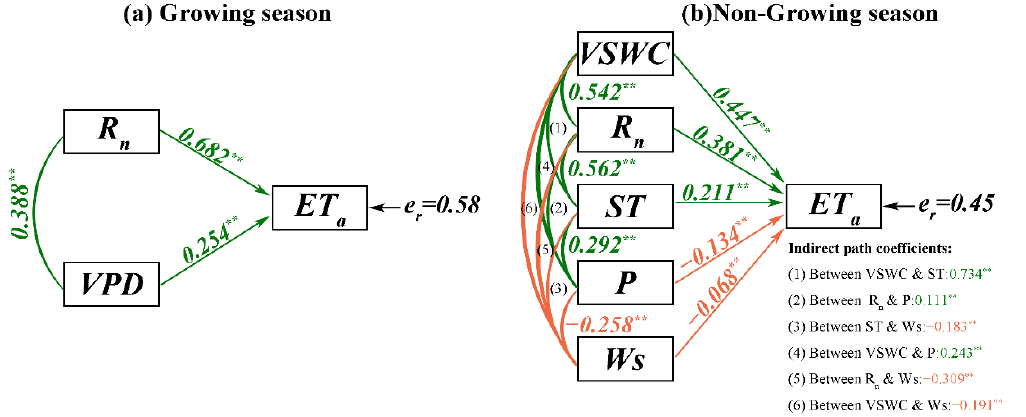
Figure 8. The structures of MF G and MF NG given by path analysis during the ( a ) growing season and ( b ) non-growing season. One-way influence was shown with arrows; the interplay of environmental elements is represented by the line without arrows. Additionally, the green and orange colors implied positive and negative relationships between the actual evapotranspiration (ET a ) and environmental elements, respectively. e r indicates that the residual error was calculated by e r = (1-R 2 ) 1/2 . The asterisk superscript implies that the value passed the 95% significance t -test.